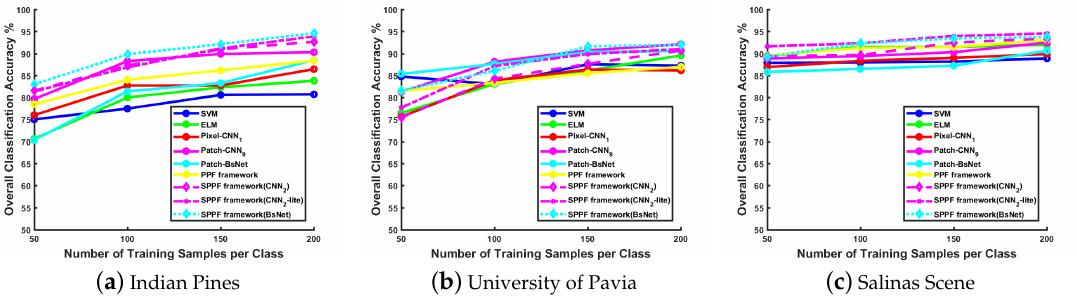
Figure 3. Stability comparison results on three datasets with increasing number of training samples. Generally, more training samples result in models having better